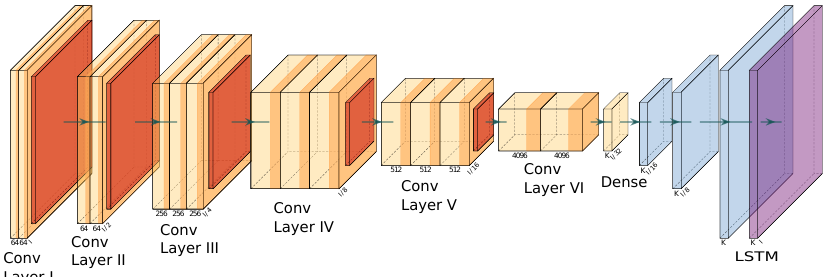
Figure 6. Example of a CNN with six convolutional